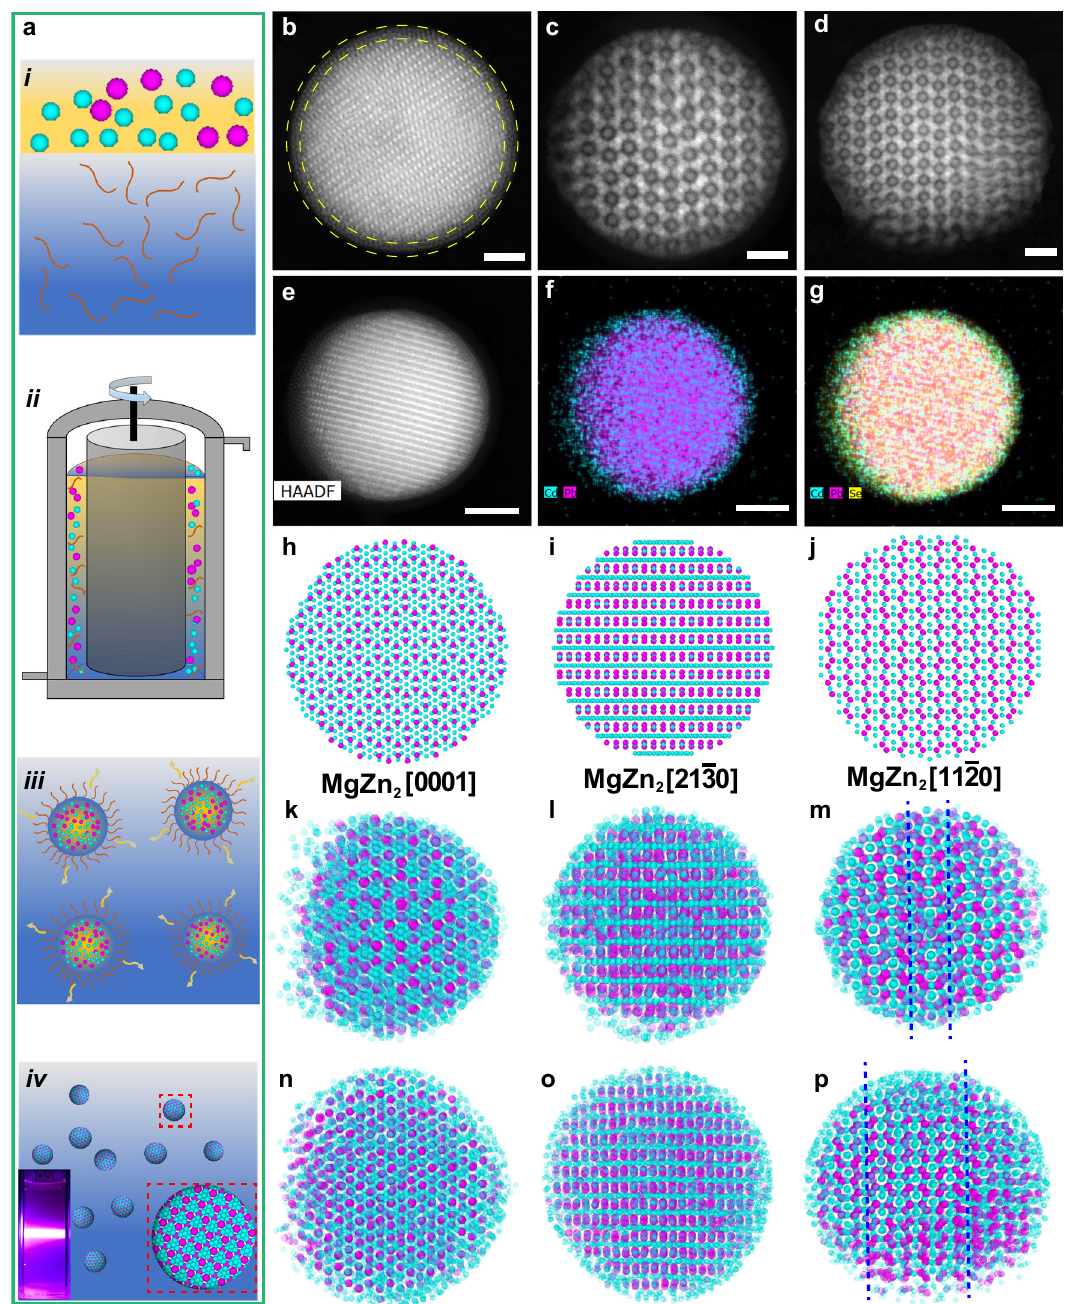
Fig. 3 Self-assembled binary Laves SPs. ( a ) Schematic illustration of the formation of Laves phase binary SPs via a drying emulsion droplet method. ( b ) 2D HAADF-STEM image of a self-assembled SP with the core-shell structure highlighted by yellow dashed circles. 2D HAADF-STEM projections of ( c ) a 115 nm-sized SP, ( d ) a 150 nm-sized SP and ( e ) a SP for EDX chemical mapping study projection. Superimposition of ( f ) Pb and Cd and ( g ) of Pb, Cd and Se. Magenta, cyan and yellow represent the distribution of Pb, Cd and Se, respectively. Structure model of a perfect MgZn 2 SP viewed along the ( h ) [0001], ( i ) [21 (cid:1) 30] and ( j ) [11 (cid:1) 20] projections, respectively. Sparse Sphere Reconstruction (SSR) 39 renderings of ( k ) – ( m ) a 115 nm-sized SP and ( n ) – ( p ) a 150 nm-sized SP viewed along the ( k ), ( n ) [0001], ( l ), ( o ) [21 (cid:1) 30] and ( m ), ( p ) [11 (cid:1) 20] projections, respectively. Stacking faults in the two SPs are marked with dark blue dashed lines. A digital micrograph of an SP dispersion excited by ultraviolet light (wavelength λ = 405 nm) as an inset of ( a )iv, showing photoluminescence of the SP dispersion at room temperature. Scale bars: 50 nm ( b ), 20 nm ( c ), 20 nm ( d ), 80 nm ( e ) – ( g ). The transparency of the binary species ( k ) – ( p ) was increased for visual clarity. For interactive 3D views of the 115 nm and 150 nm SPs, see Supplementary Data 4 –